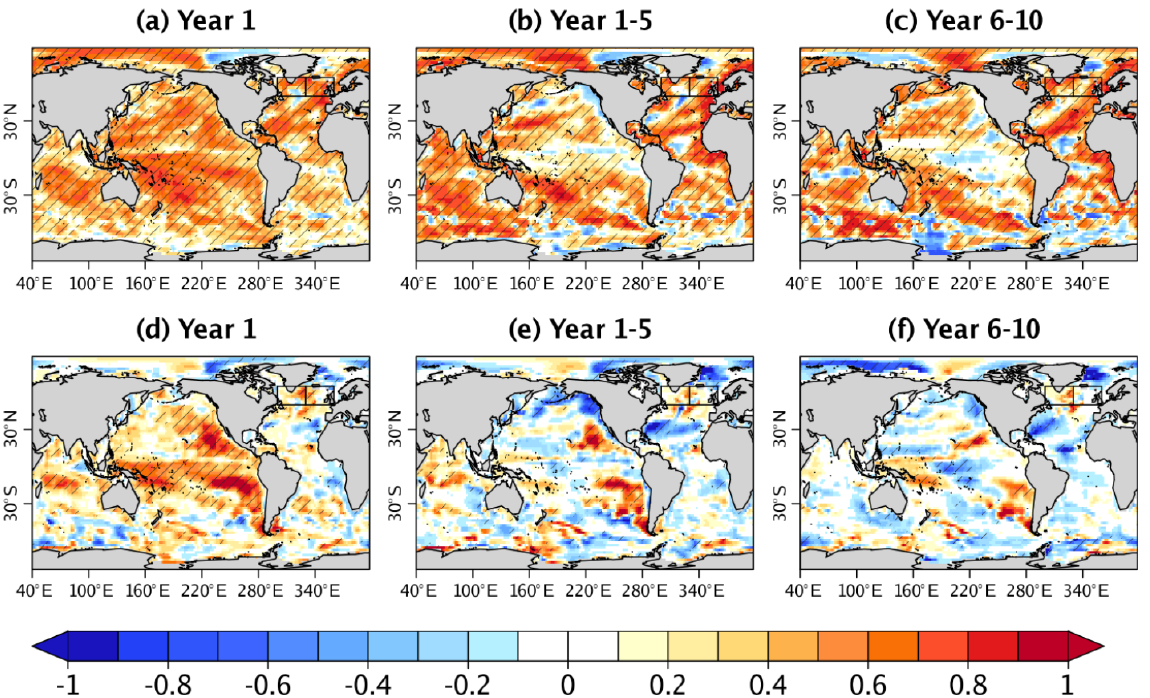
Figure 4. Upper 300m ocean heat content (OHC300) anomaly correlation coefficient (ACC) of PRED computed with the EN4 observations for (a) forecast years 1, (b) 1–5 and (c) 6–10. The impact of initialization is shown as the difference in ACC between PRED and HIST for (d) forecast years 1, (e) 1–5 and (f) 6–10. In panels (a–c) , the hatching indicates the statistical significance of the correlation at the 95% confidence level. For panels (d–f) hatching indicates the regions where the difference in correlation between HIST and PRED is statistically significant at the 95% confidence level. The black boxes in the North Atlantic delimit the region over which the SPNA indices have been defined. It also includes the central boundary used to distinguish between its western and eastern